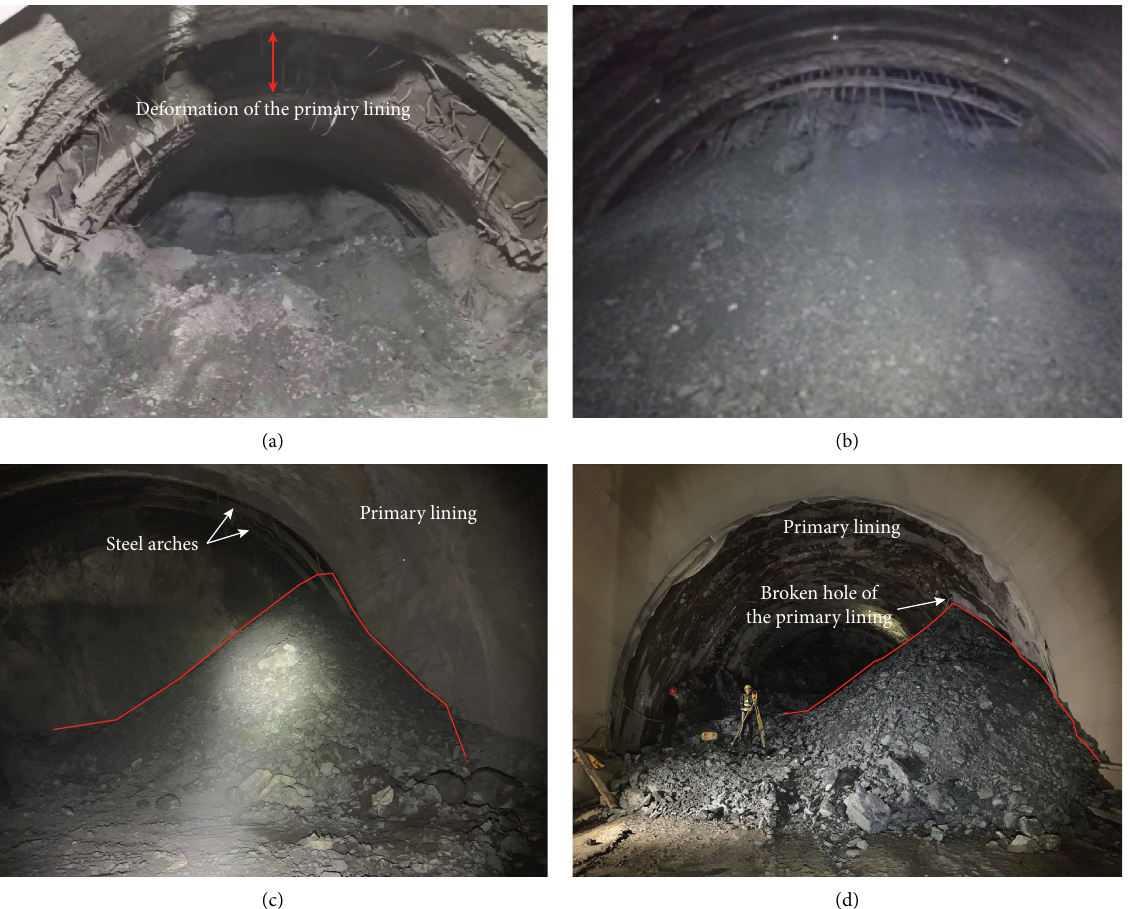
Figure 4: Engineering problems in Tayi tunnel: (a) large deformation of the primary lining due to soft surrounding rock mass; (b) collapse of the tunnel excavation face; (c) collapse of the tunnel side wall after installing steel arches but before spraying shotcrete of the primary lining; (d) broken primary lining after spraying